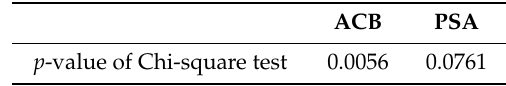
Table 3. Chi-square test result indicating the relationship of incubation temperature and biofilm